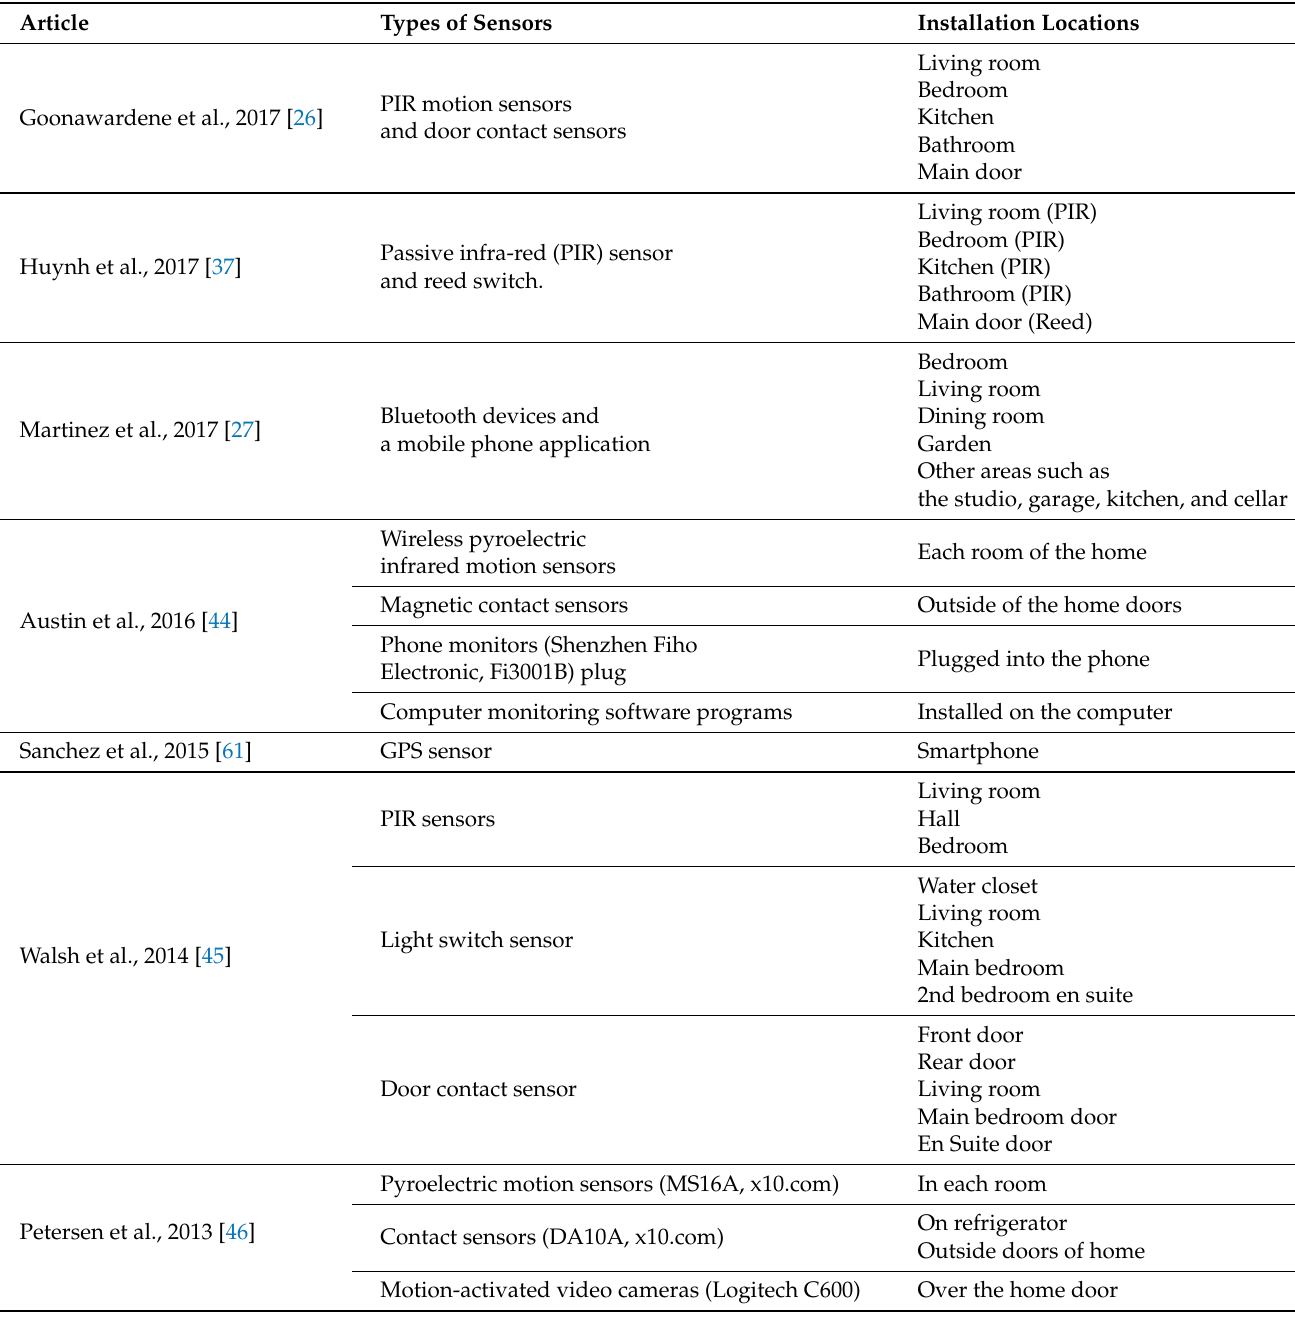
Table 6. Types of sensors and installation